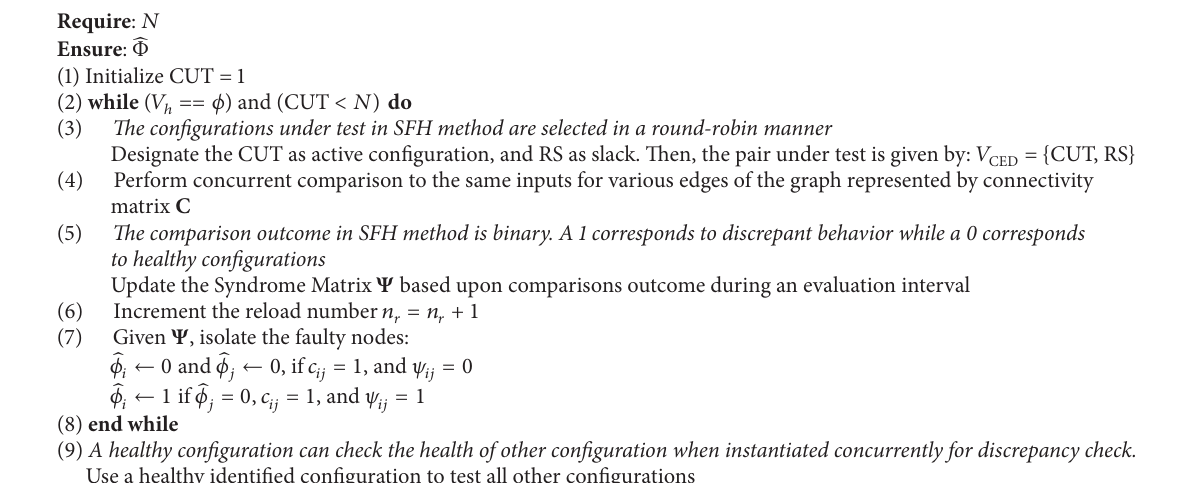
Algorithm 2: SFH state transition algorithm for functional diagnosis of